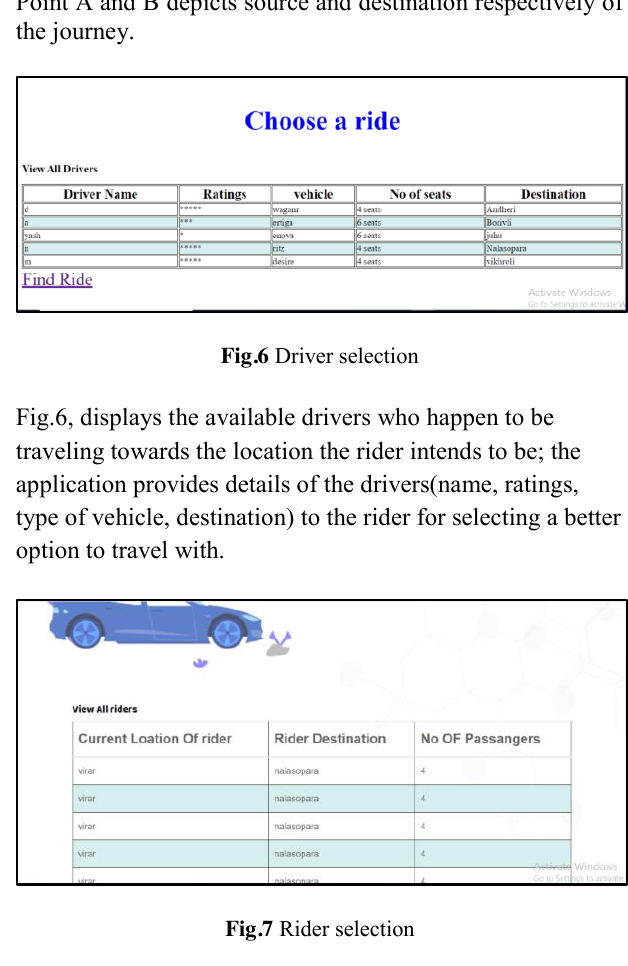
Table 1: Comparison of Traditional System and Proposed